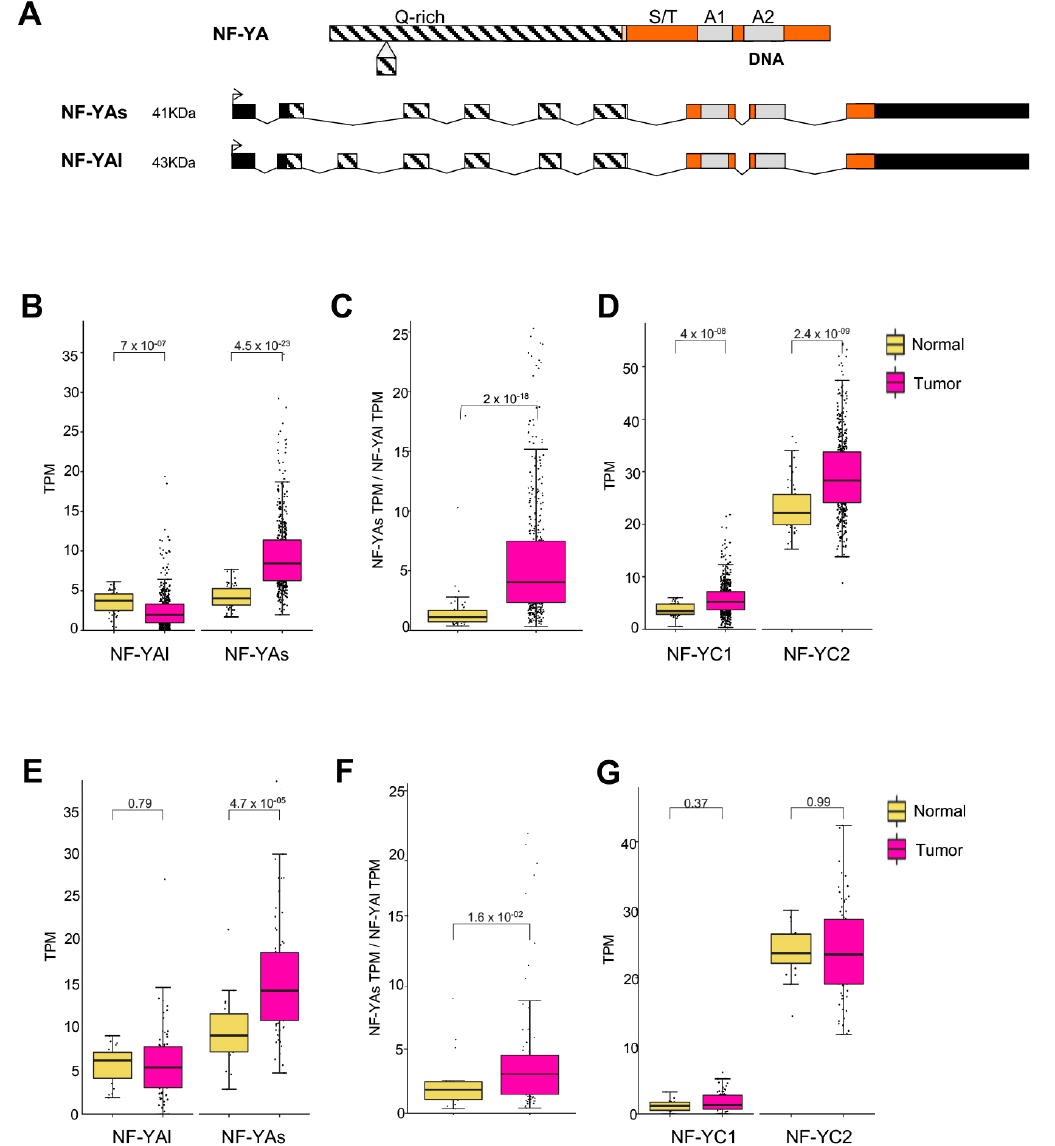
Figure 2. NF-YA short isoform is overexpressed. ( A ) Scheme of the NF-YA exons, with the NF-YAl and NF-YAs isoforms indicated. Q-rich, trans activation domain. S / T, serine / threonine-rich domain. A1, helix 1, subunits-interaction domain. A2, helix 2, DNA-binding domain. ( B ) Box plots of expression levels of NF-YAs and NF-YAl in the TCGA dataset. ( C ) Relative ratios of NF-YAs / NF-YAl. ( D ) Expression levels of NF-YC isoforms in TCGA LUSC. NF-YC1, 50 kD isoform. NF-YC2 37 kD isoform. ( E ) Expression levels of NF-YAs and NF-YAl in TCGA and GSE81089. ( F ) Relative ratios of NF-YAs / NF-YAl. ( G ) Expression levels of NF-YC isoforms in TCGA and GSE81089.